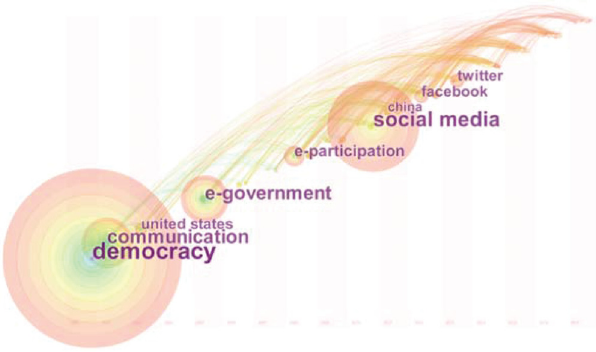
Figure 2. The time-zone